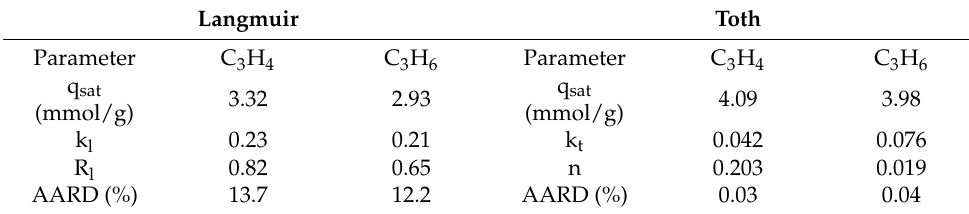
Table 4. Isotherm model fitting